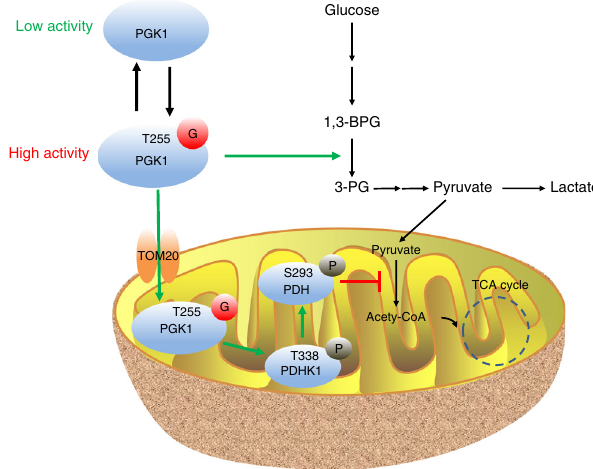
Fig. 9 A graphic model of PGK1 O-GlcNAcylation in coordination of glycolysis and TCA cycle to promote tumor growth. T255 O- GlcNAcylation activates PGK1 enzymatic activity, and simultaneously induces PGK1 translocation into mitochondria for the subsequent phosphorylation-dependent inhibition of pyruvate metabolism. Thus, PGK1 O-GlcNAcylation promotes the Warburg effect and contributes to colon cancer